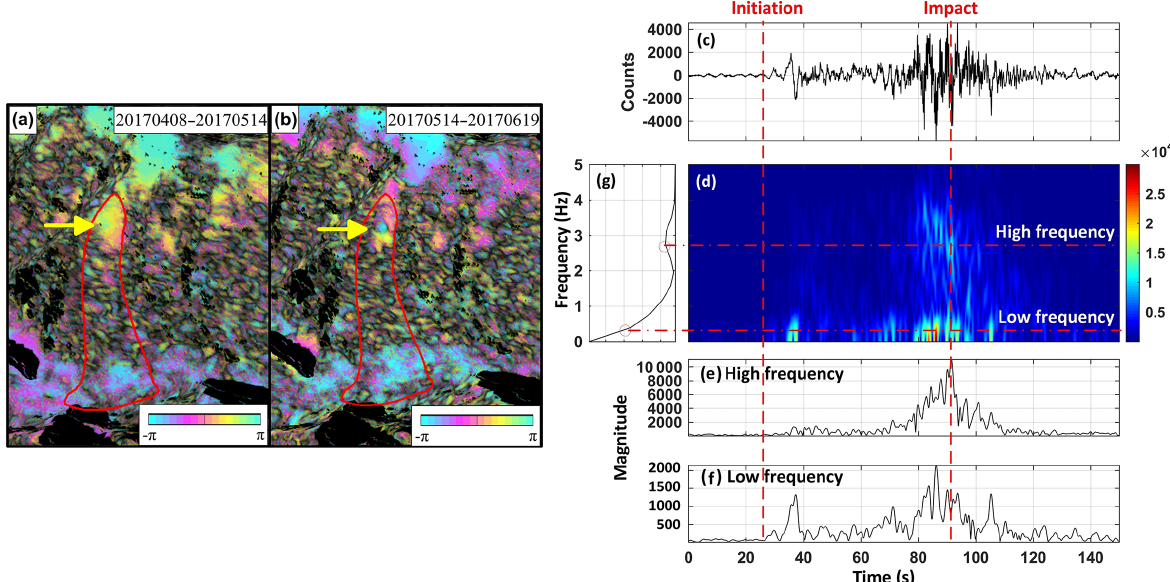
Figure 3. (a, b) Differential interferogram of the landslide obtained by processing Sentinel-1 satellite data. The arrow points to the deforma- tion occurred in the landslide source area. (c–g) Seismic signal of the Xinmo landslide event recorded by the Maoxian MXI station, about 43km apart (modified from Fan et al., 2017): vertical component (c) ; frequency–time Hilbert spectrum (d) ; high-frequency time–magnitude spectrum, f = 2.73Hz (e) ; low-frequency time–magnitude spectrum, f = 0.4Hz (f) ; frequency–magnitude spectrum (g)